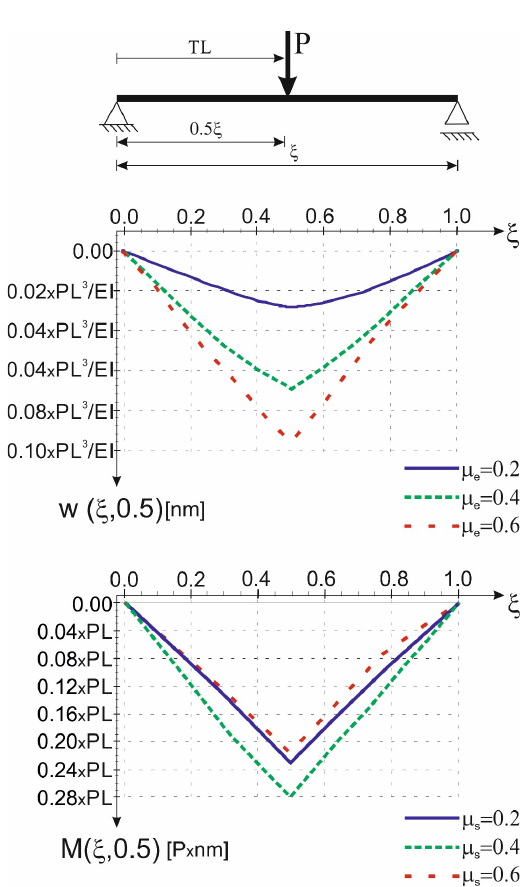
Figure 2: Stress gradient model. Displacement and bending moment η = . of the beam for 0.5 T = , 0.01 g